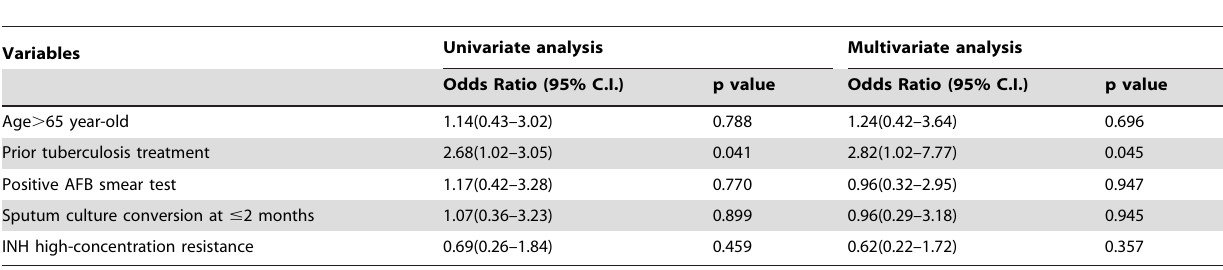
Table 5. Univariable and multivariable associations with unsuccessful treatment outcome.